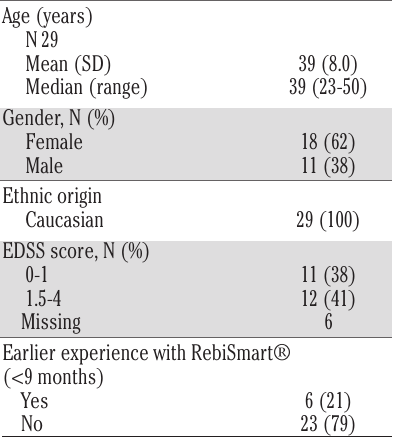
Table 1. Patients’ demographics and base- line characteristics.